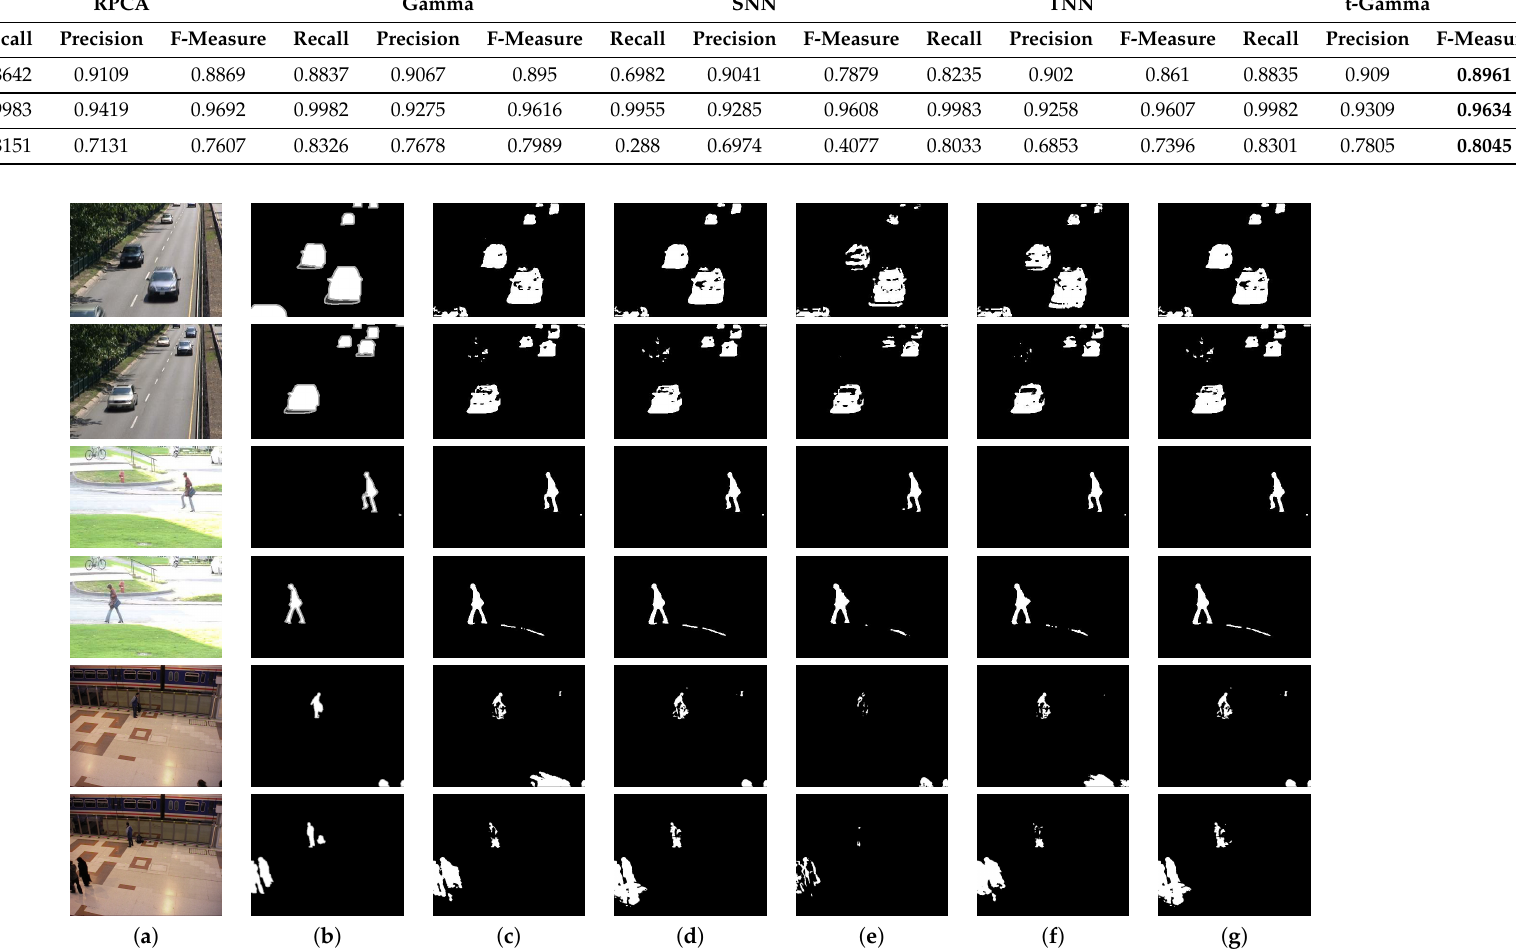
Figure 7. Visual results for CDNet dataset. Row 1 and row 2 are samples of highway ; row 3 and row 4 are samples of pedestrians ; row 5 and row 6 are samples of PETS2006